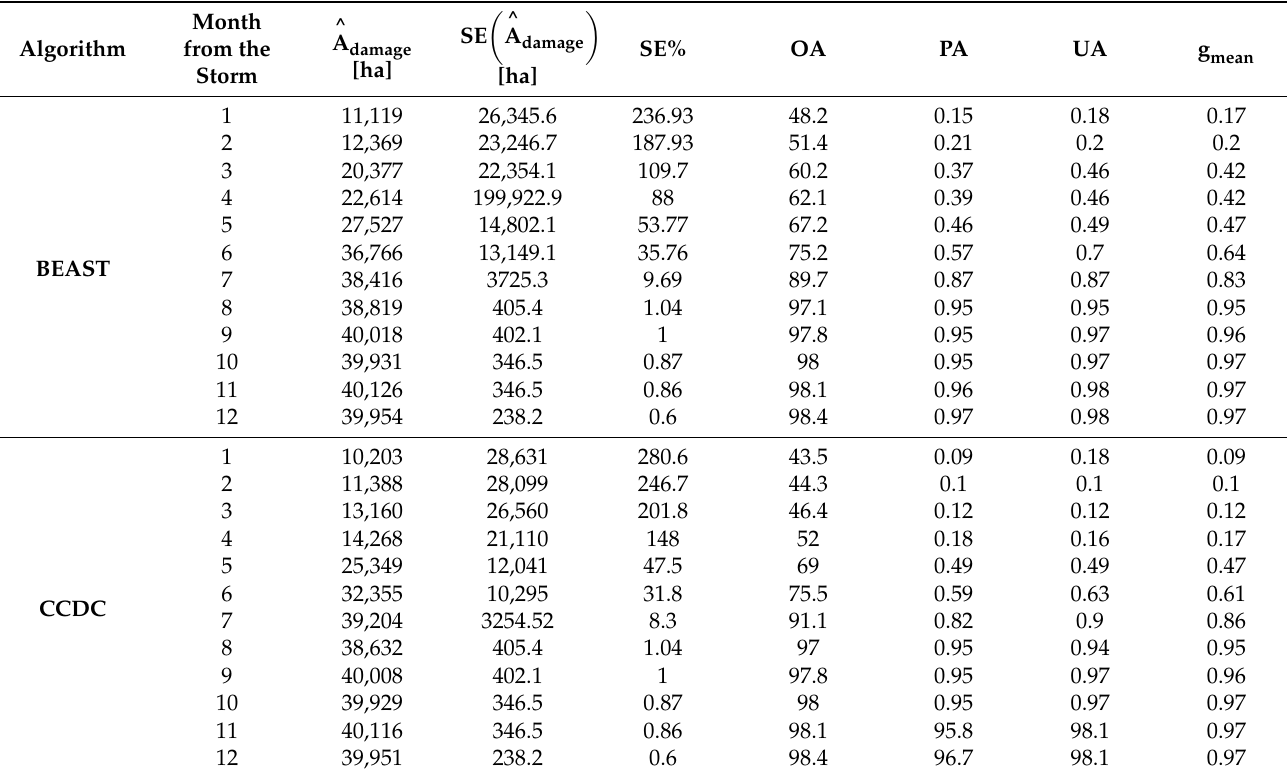
(cid:16) (cid:17) ˆA ;SE% ) and accuracy assessment (OA = Overall Accuracy, damage